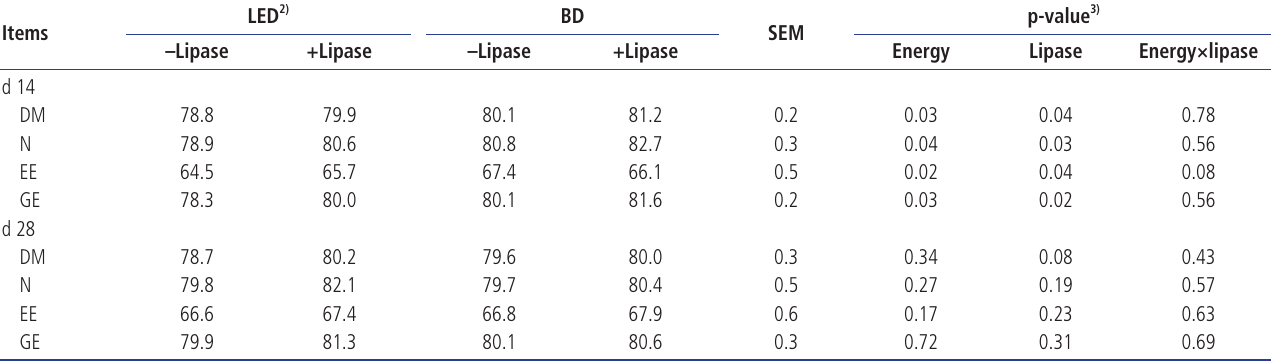
Table 3. Effects of dietary energy and lipase levels on apparent fecal digestibility of nutrients in weaning pigs 1)